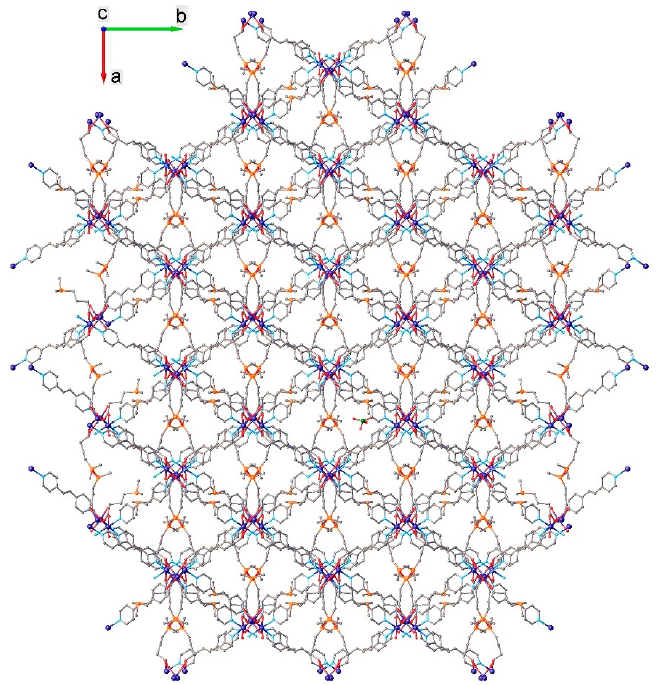
Figure 4. The crystal structure of compound 1.